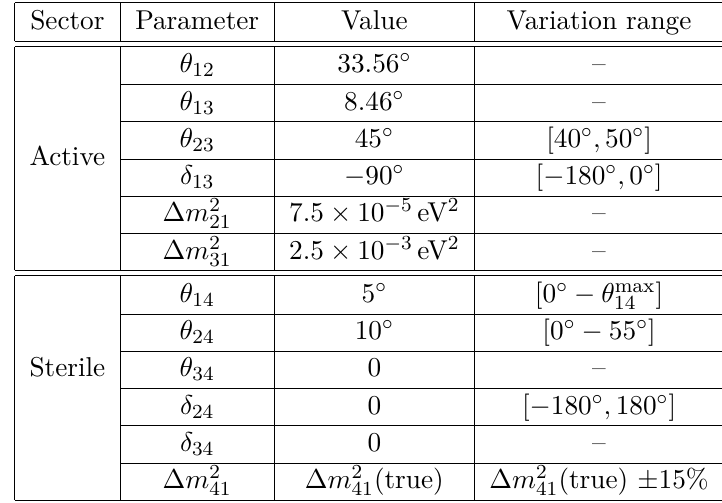
Table 3 . The simulated (true) values of parameters in the active and sterile sectors, and the variation ranges taken for their test